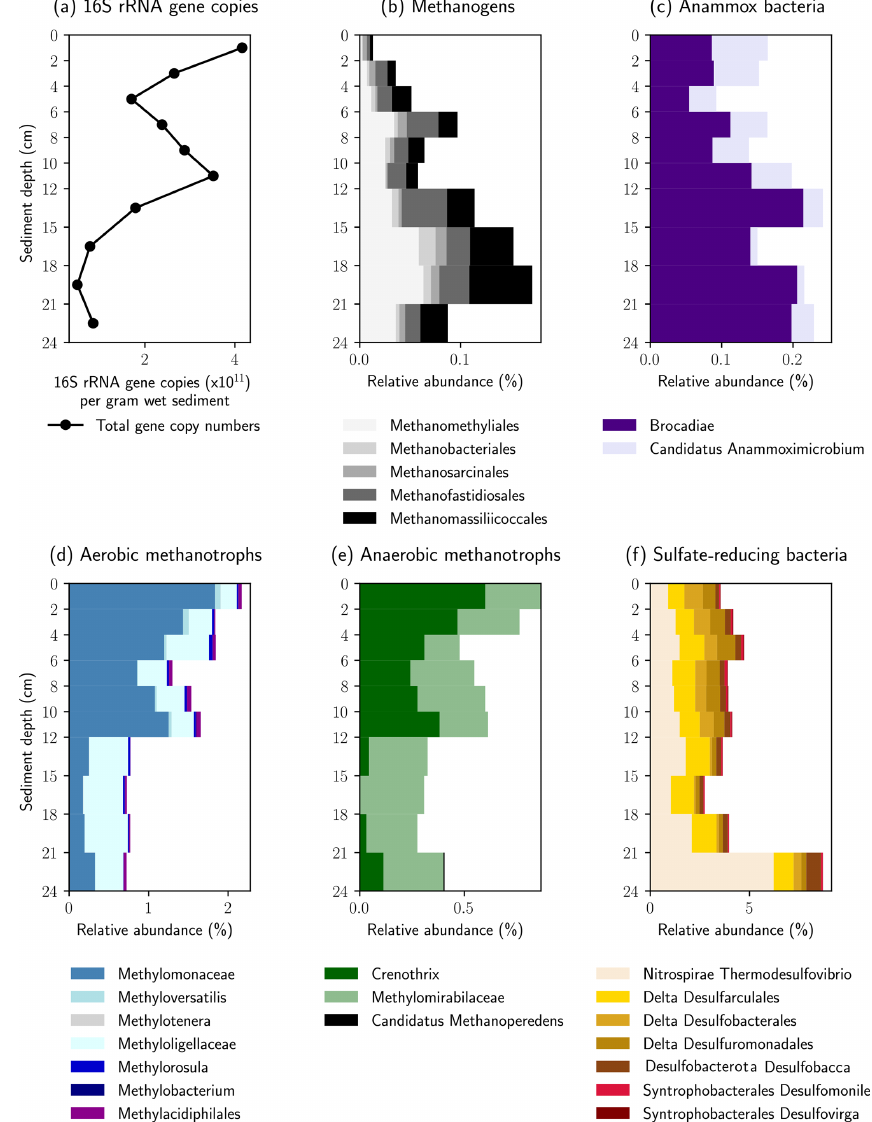
Figure 5. Relative abundance of key microbial groups detected in the 16S rRNA gene sequencing datasets. The histograms display the relative abundance (percentage of total reads) assigned to each group displayed. Note the increase in relative abundance of methanogenic groups below 12cm, whereas the relative abundance of methane oxidizing groups increases above